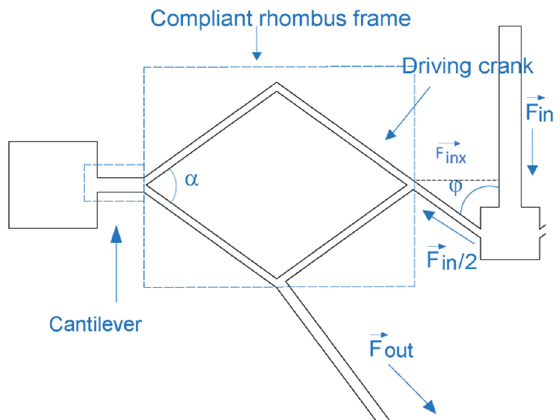
Figure 6. Elements of microgripper symmetric arm.